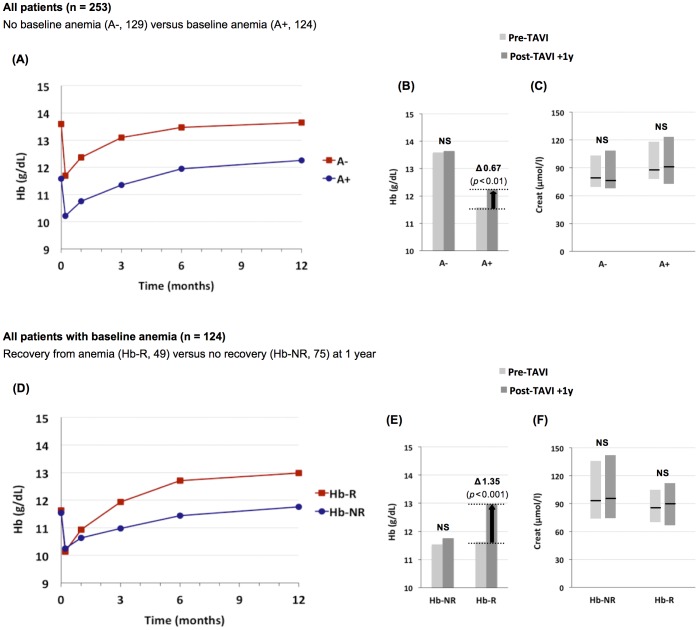
Impact of TAVI on baseline anemia and renal function.(A–C) Results in all patients (n = 253) dichotomized by the presence of baseline anemia (A+) versus no baseline anemia (A−). (D–F) Results in all patients with baseline anemia (n = 124) dichotomized by recovery from anemia (Hb-R) versus no recovery from anemia (Hb-NR) at 1 year after TAVI. Hb, hemoglobin; Creat, creatinine; NS, not significant.